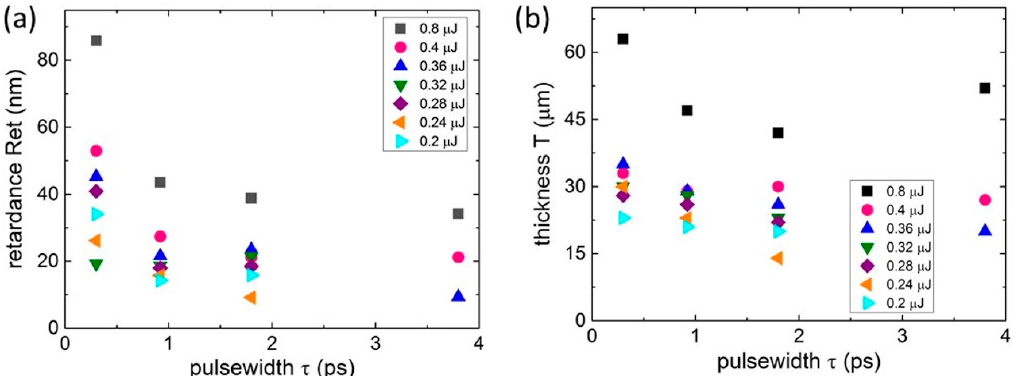
Figure 3. Retardance Ret ( a ) and thickness T ( b ) magnitudes versus pulsewidth τ at different 1030 nm laser pulse energies (symbols of different shapes and colors). Maximal relative error bars ≤ 10%.